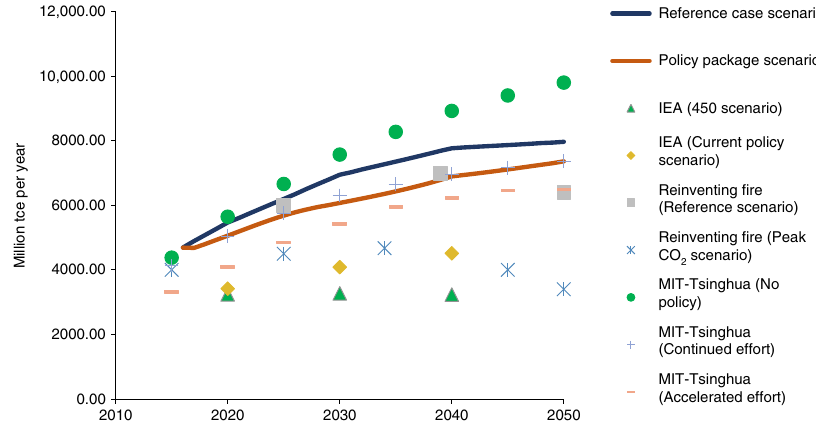
Fig. 5 Total primary energy use in China under different scenarios. The results of the policy package scenario in our modeling show that existing climate change policies will limit growth in China ’ s absolute energy consumption but will not enable it to reach a peaking point. Total primary energy use in China continues to increase but gradually transitions to a slower pace after 2040. To achieve the peak in energy use advanced by the IEA 18 and Reinventing Fire scenarios, nine more stringent policies would be needed